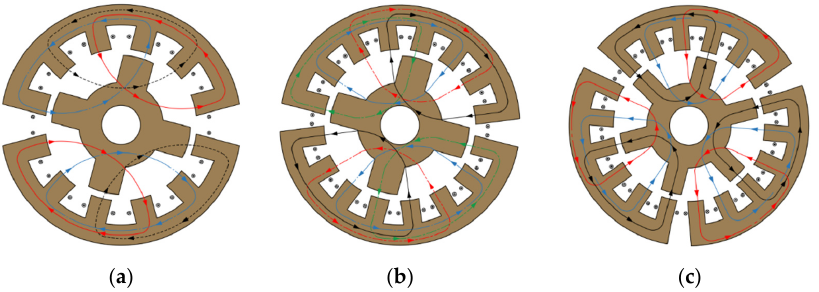
Figure 16. Structures of FRFS-SRMs. ( a ) three phase two segments SRM; ( b ) four phase two segments SRM; ( c ) three phase and three segments SRM.